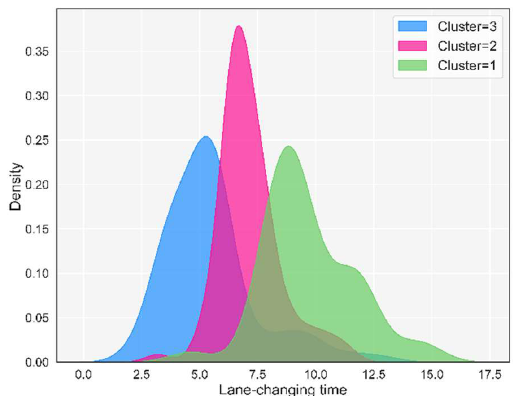
Figure 11. The density map of lane-changing time.